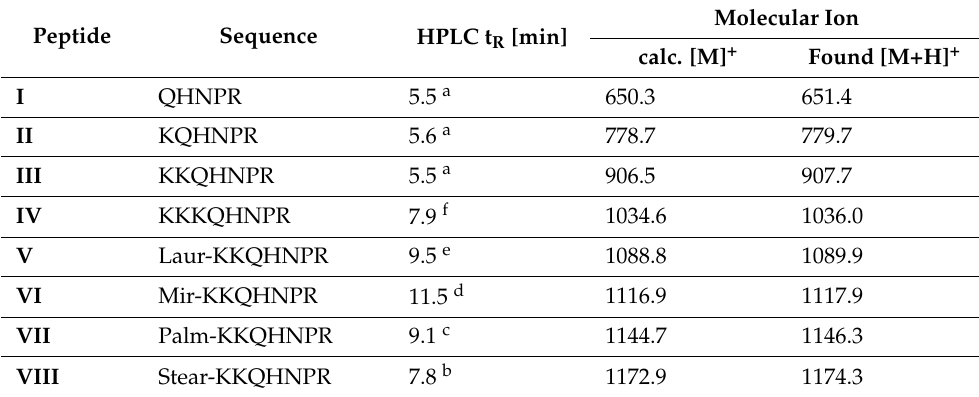
Table 1. Physicochemical properties of peptides I – VIII